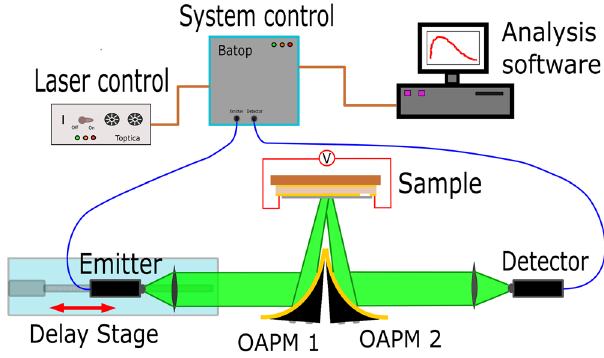
Fig. 7 Experimental setup for device measurement. Terahertz time- domain spectroscopy in re fl ection geometry. The THz wave is emitted and detected by photoconductive antennae (PCAs), with the THz beam focussed (~5 mm spot size) and re-collected from the sample via two off- axis paraboloid mirrors (OAPM 1 and 2). In this setup, the graphene/gold bilayer metasurface frequency-selective absorber acts as a single-port electrical